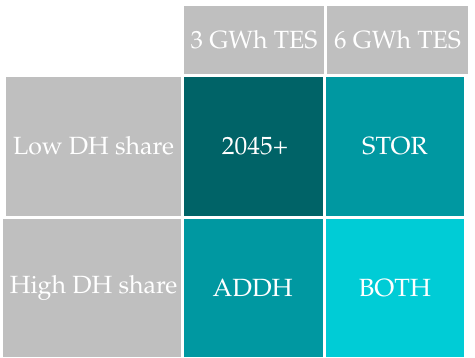
Figure 10. Names of the sensitivities, varying DH penetration and thermal storage